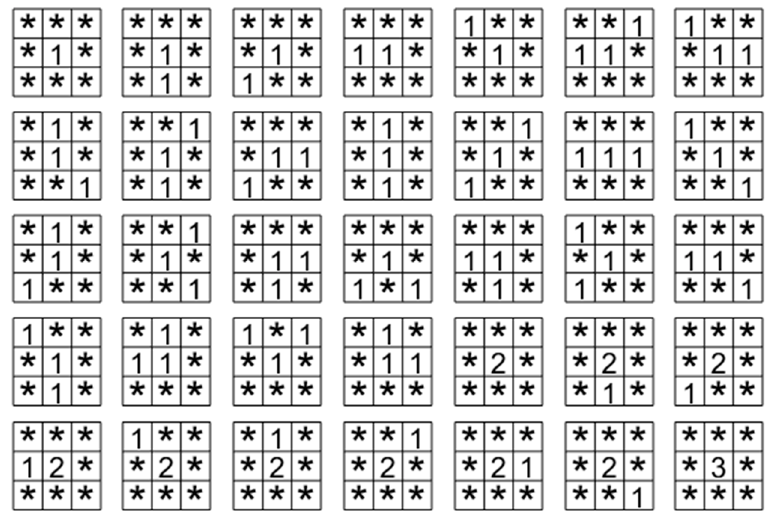
Figure 6. The 35 displacement masks used for calculating higher-order local autocorrelation (HLAC) feature descriptor. In each mask, the values represent the reference locations used in multiplying with the image intensities and * represents do not care locations [25].